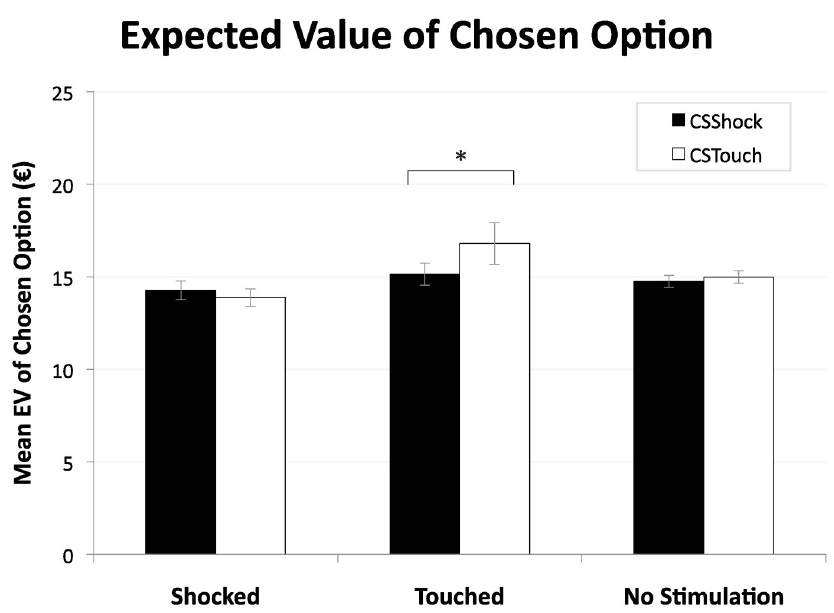
Fig 5. Mean expected value (in Euros) of the chosen option for CS Shock - and CS Touch -trials as a function of reminder (i.e., proceeding a trial in which a Shock, a Touch, or no electro stimulation was given). Error bars depict standard error of the mean. Note . � p <